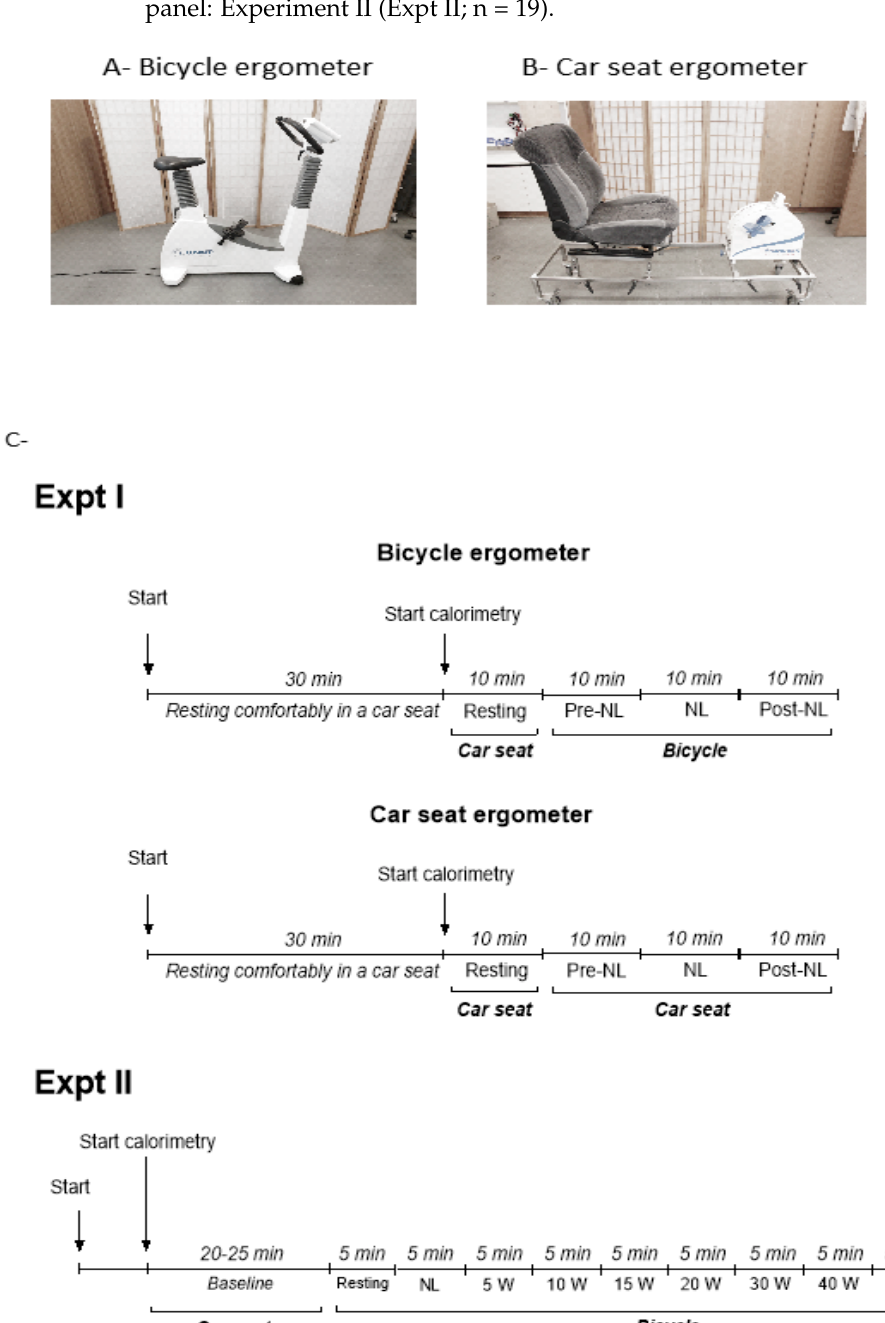
Figure 1. Photographs of the two types of cycling ergometry utilised ( A , B ) and experimental design illustration ( C ). NL = no-load cycling: sitting (car seat or bicycle) and cycling at 60 rpm at no-load. Panel A : the bicycle ergometer (Cosmed E100 P, Milan Italy). Panel B : the car seat